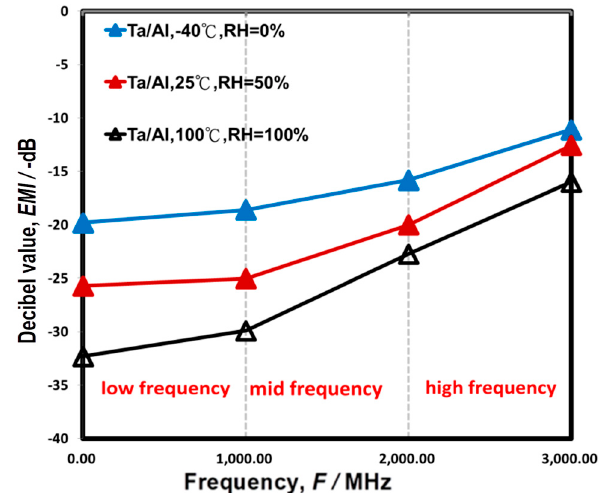
Figure 8. EMI shielding of Ta (200 nm)/Al (50 nm)/glass samples with different temperatures and humidity.